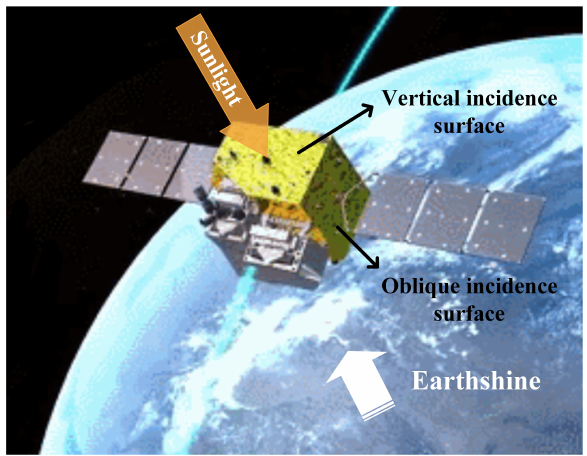
Figure 1. Schematic of the space target attitude and